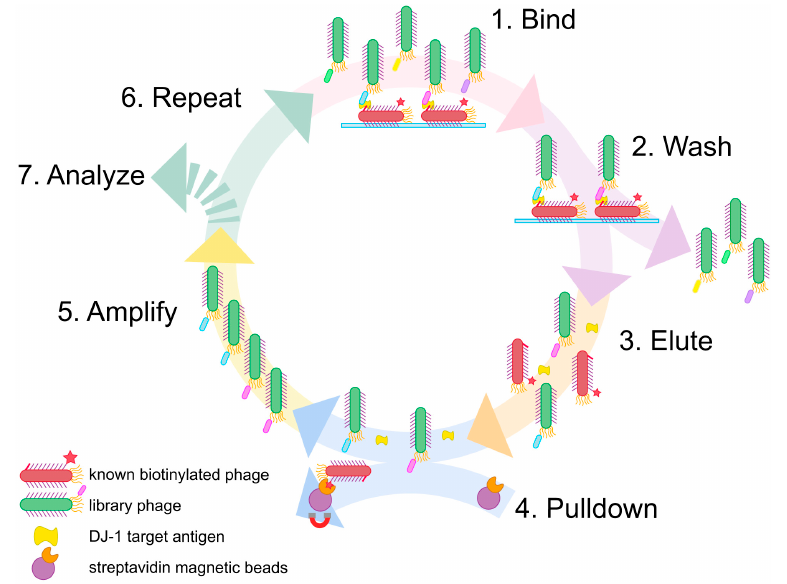
Figure 1. Phage vs. phage selection strategy. (1) Biotinylated phage displaying the known binding partner are adsorbed to a microtiter plate and exposed to the target. Next, the phage library is added and allowed to bind. (2) Nonbinding phages are removed by washing. (3) Sandwich assemblies are eluted from the microtiter plate by treatment with low pH solution and sonication. (4) In the eluate, biotinylated phage display with the known binding partner can removed from the solution through binding to magnetic streptavidin beads. (5) The sandwich forming pair of phages are used to infect E. coli and amplified. (6) The process is repeated with the amplified selectants as the phage library for the next round of selection. (7) After three to four rounds of selection, the selectants are identified by DNA